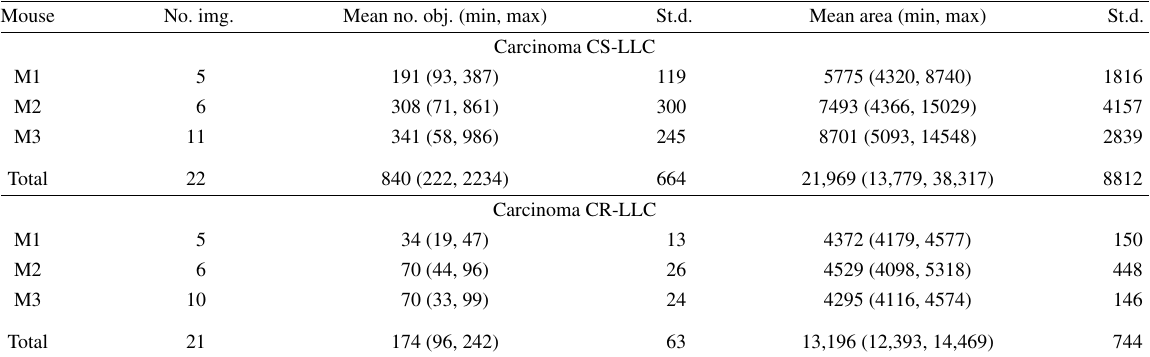
Quantification of the Cy5.5 annexin histological appearance in (a) CS-LLC and (b) CR-LLC tumors